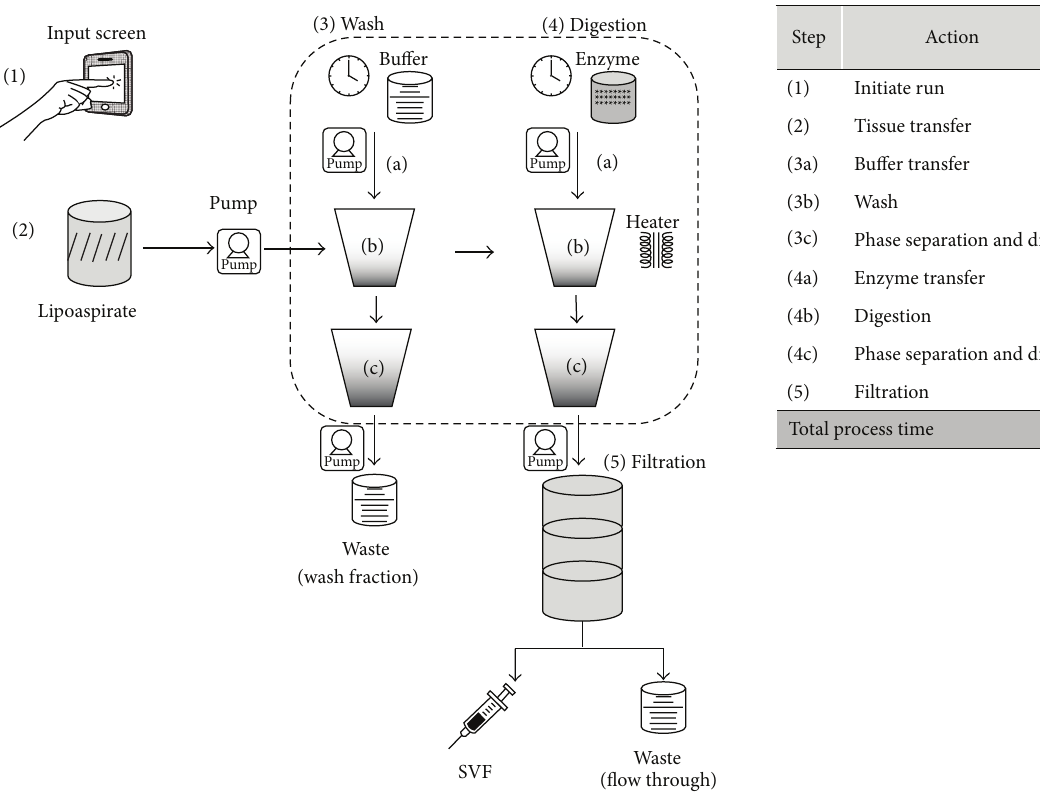
Figure 3: Schematic representation of the automated process for isolation of SVF from lipoaspirate tissue. The schematic represents the various steps involved in SVF isolation. (1) The automated run is initiated by the user via a graphical user interphase; (2) lipoaspirate tissue is transferred into the tissue processing unit with the help of pump; (3) wash sequence comprises of (3a) transfer of buffer into the tissue processing unit with the help of pump, (3b) washing of tissue by agitation, and (3c) phase separation into upper fat and lower aqueous phases, followed by removal of the lower aqueous phase. The wash sequence is repeated thrice for complete removal of blood and tumescent fluids fromthefattissue;(4)thetissueisenzymaticallydigested.Adigestionsequencecomprisesof(4a)transferofenzymeintothetissueprocessing unit with the help of pump, (4b) the tissue is digested under controlled temperature and constant agitation, (4c) phase separation into upper fat and lower aqueous phases, and (5) the aqueous fraction of the digest is concentrated by filtration to deliver the SVF. The time taken for each of the process steps is shown in the accompanying table. Total process time is 133